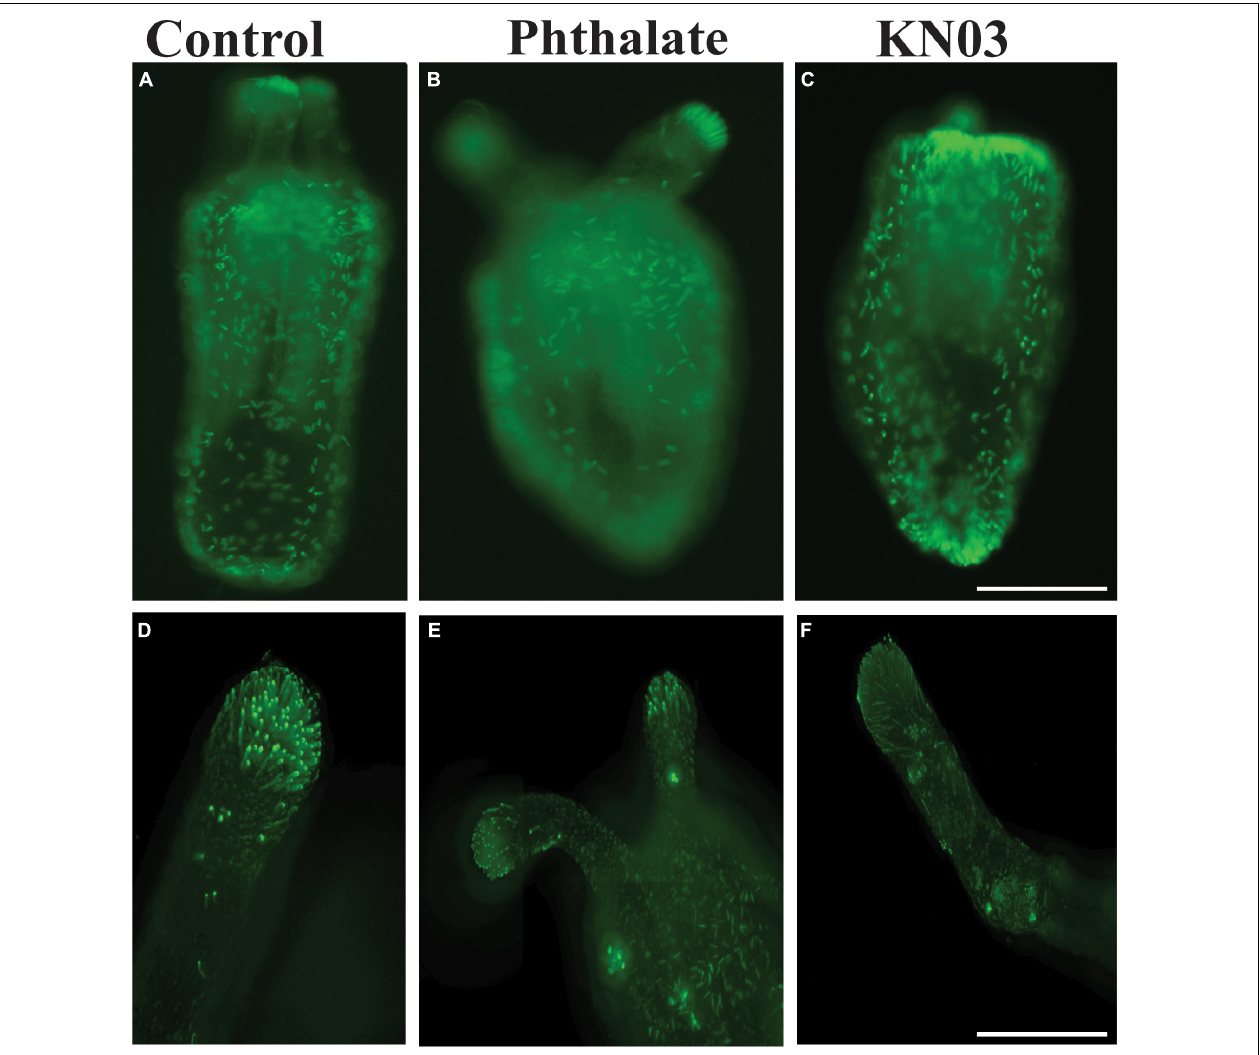
FIGURE 4 | Common environmental stressors cause defects in cnidocytes. (A) DAPI staining showing cnidocytes all over the outer body wall (A) and on the tentacle (D) . Embryos exposed to phthalates appear to have fewer cnidocytes all over the body (B) , especially on the tentacles (D) . Similarly, embryos exposed to KNO 3 have slightly less cnidocyte on the body (C) . Higher magnification images of the tentacles show fewer cnidocytes (D,F) . (A–C) , 10 × Scale bar = 500 µ m (D–E) , 20 × , Scale bar = 50 µ